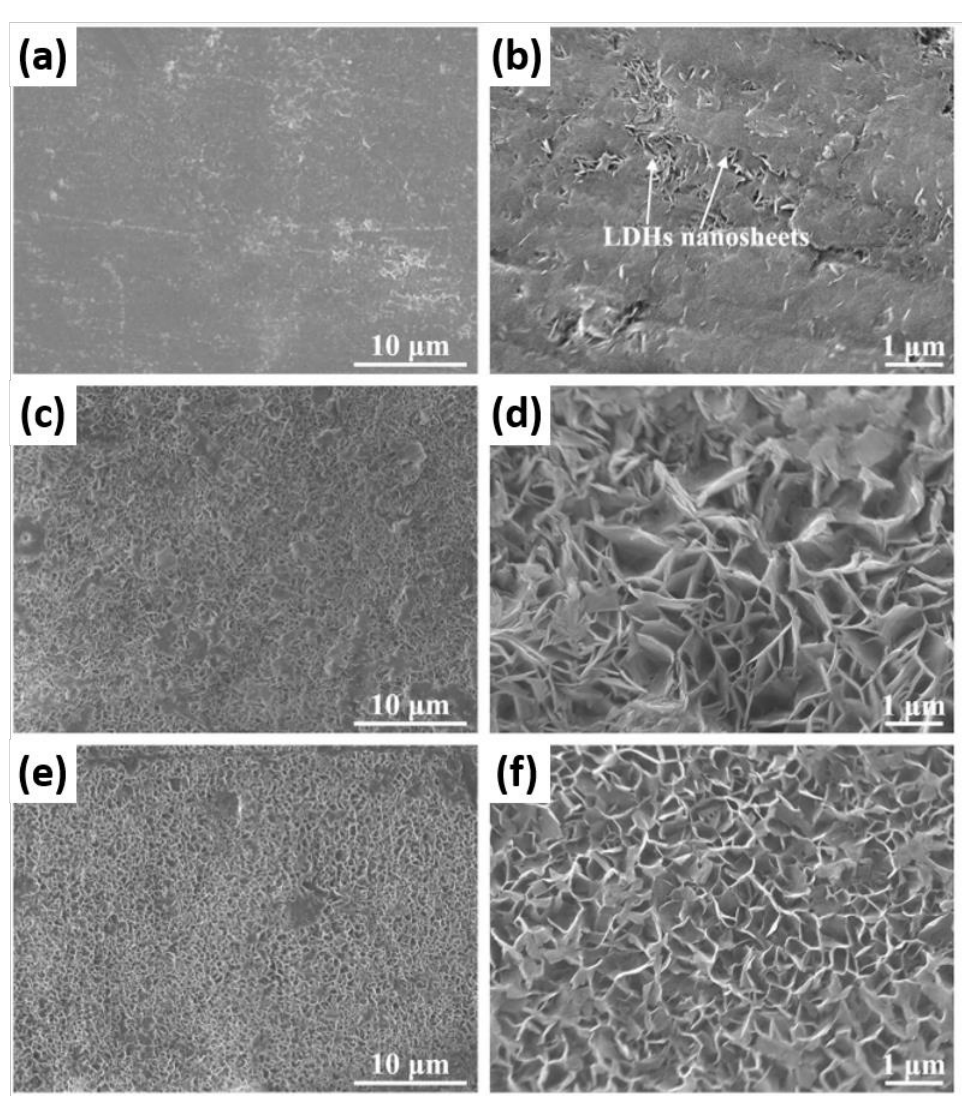
Figure 18. SEM surface micrographs of ( a , b ) MgAl-NO 3 − -LDHs, ( c , d ) MgAl-MoO 4 2− -LDHs, and ( e , f ) MgAl-SDS-LDHs. Adapted from [231] with permission from Elsevier.